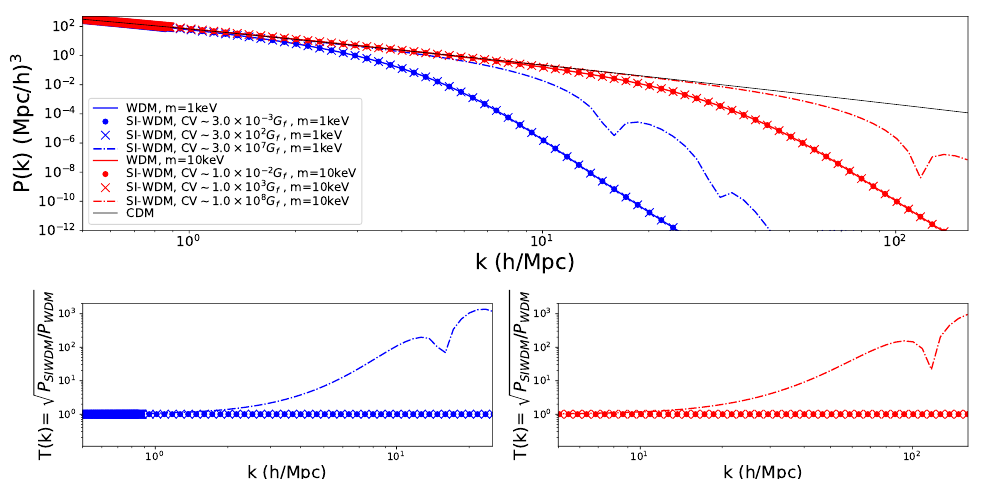
Figure 15. Power spectrum ( top panel ) and transfer functions compared to standard WDM ( bottom panels ) for a vector field SI-WDM model, using a modification to CLASS. We assume the relaxation time approximation and consider two values of the DM particle mass: 1 and 10 keV. Also plotted are the power spectra of the CDM and WDM models with a DM mass of 1 and 10 keV. All WDM and SI-WDM models consider a nonresonant production scenario (Dodelson–Widrow mechanism [86]) with T ∼ ( 4/11 ) 1/3 T γ . Importantly, the effect of large enough self-interactions increases the amount of small structure formed for these models (see dot-dashed curves), implying that the few-keV (traditional) WDM models, which were excluded in the past, can now display agreement with observations in this new SI-WDM scenario. Reproduced from [85], with permission from